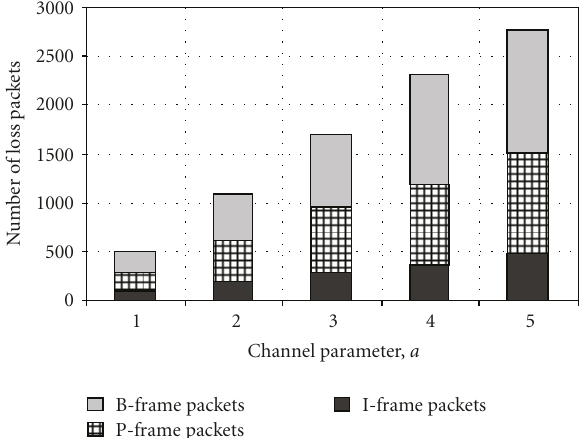
Figure 17: Comparison of PSNR for the “News” video clip between the Bluetooth default and FLC ARQ schemes with